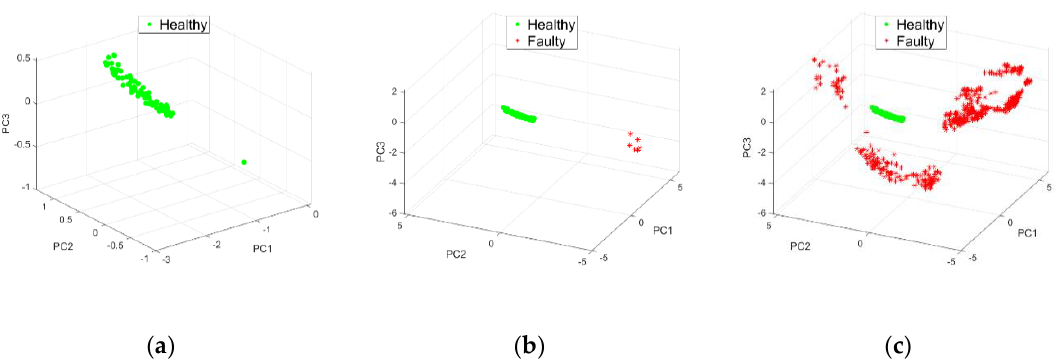
Figure 9. Experimental validation ( a ) Iteration 10, ( b ) Iteration 11 and ( c ) Iteration 90.